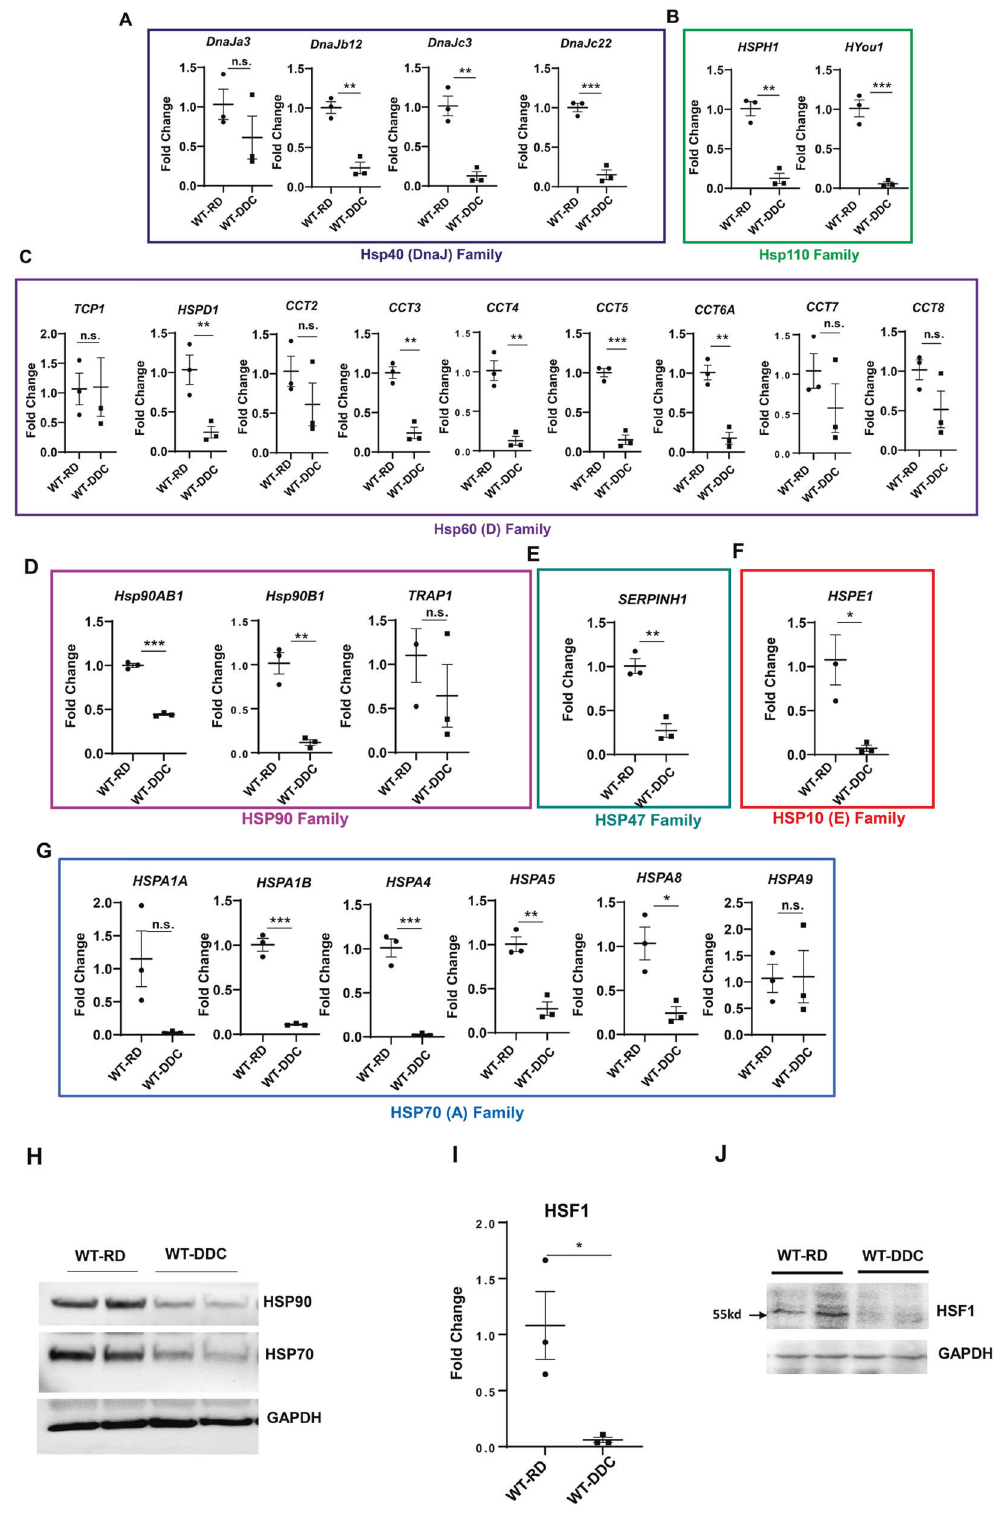
Fig. 2 Liver protein chaperonin system is suppressed by DDC. Quantitative PCR analysis for A Hsp40 (DnaJ) Family, B Hsp110 Family, C Hsp60 Family, D HSP90 Family, E HSP47 Family, F HSP10 E Family, G HSP70(A) Family Hsp ’ s mRNA expression in 9-week-old mice wild type mice fed with RD and 2 weeks of DDC diet. The mRNA expression levels were normalized to actin. H Total liver lysates from 9-week-old mice were analyzed by immunoblotting for HSP90, HSP70, and GAPDH. I – J HSF1 protein and mRNA expression in 9-week-old mice wild-type mice fed with regular diet (RD) and 2 weeks of DDC diet. Data are expressed as the mean ± SEM. n.s not signi fi cant, * P ≥ 0.05, ** P ≥ 0.01, *** P ≥ 0.001 ( n = 3).